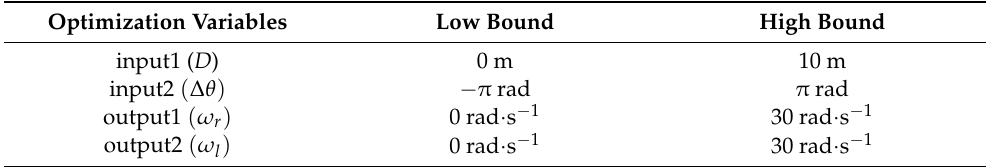
Table 8. The limit of the optimization problem variables.